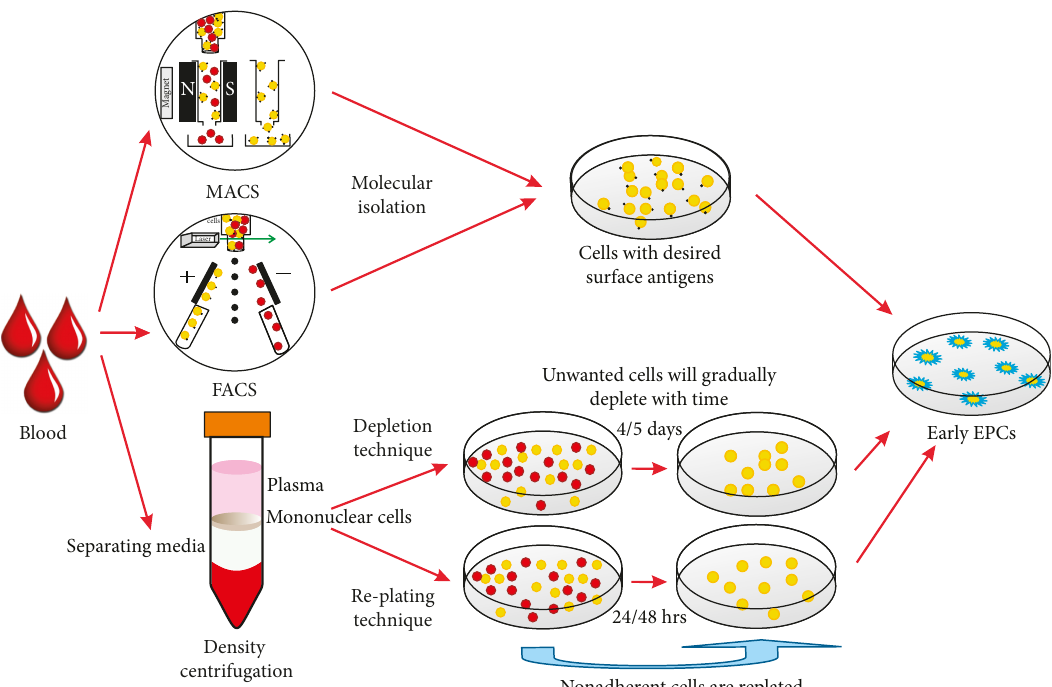
Figure 4: Isolation of EPCs by various